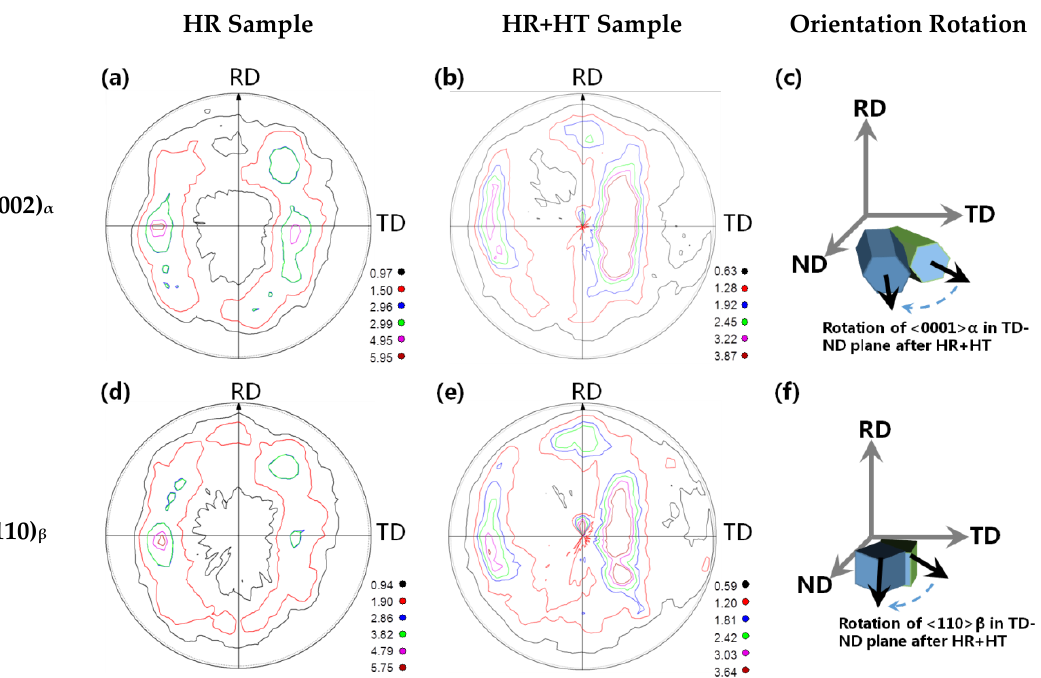
Figure 4. (0002) α and (110) β pole figures of HR and HR+HT samples. ( a – c ): (0002) α ; ( d – f ): (110) β .